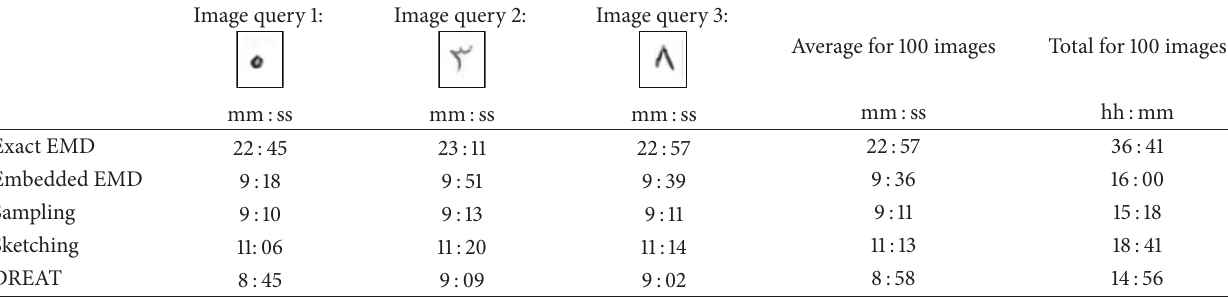
Table 8: Time execution of 3 reference images and estimation for 100